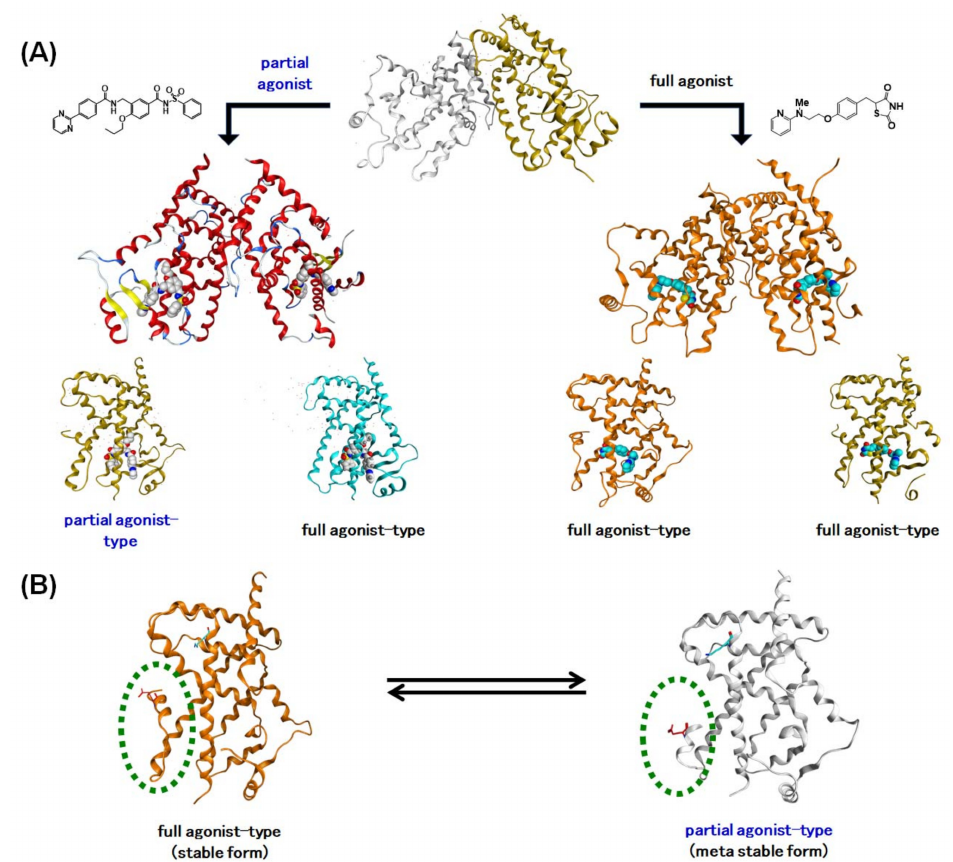
Figure 26. ( A ) Schematic representation of complexation of PPAR γ agonists with the apo-type PPAR γ homodimer. Full agonists induce structural change of the non-fully active hPPAR γ LBD to the fully active LBD, presumably by facilitating a tight hydrogen bond network with the LBD, especially to the C-terminal region (H12). hPPAR γ partial agonists lack the ability to induce the fully active LBD. ( B ) Schematic representation of the dynamic equivalence between the full agonist form of the hPPAR γ LBD and the partial agonist form of the hPPAR γ